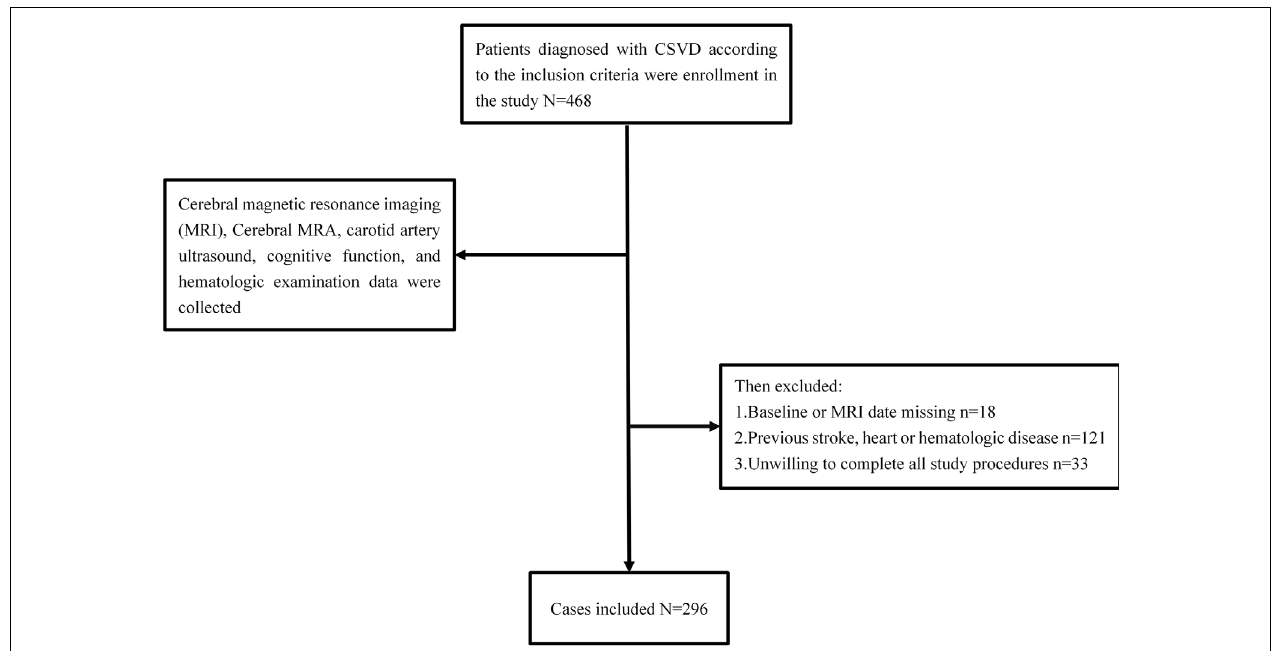
FIGURE 1 | Flowchart of patients included in this